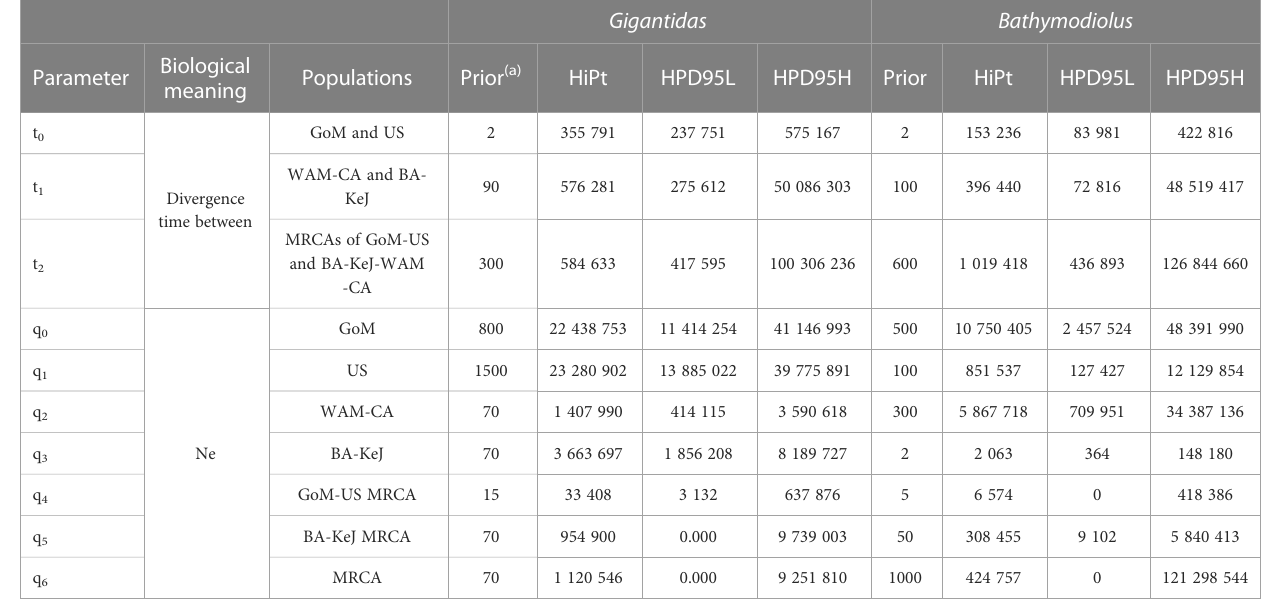
TABLE 2 Priors and estimates values of IMa3 demographic parameters for the two species complex. Gigantidas